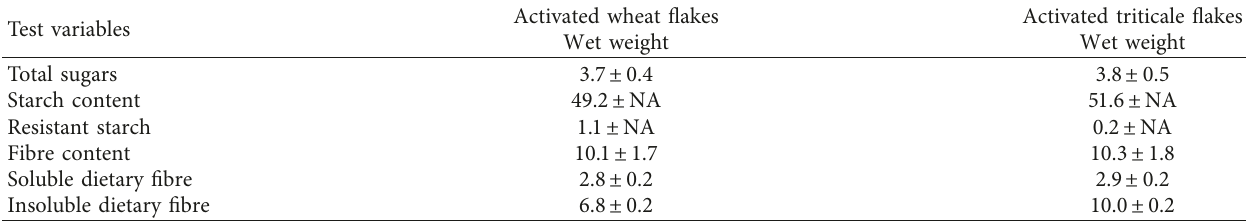
Table 1: Mean carbohydrate content (expressed in % ± SD) in activated wheat and triticale grain flakes. Test